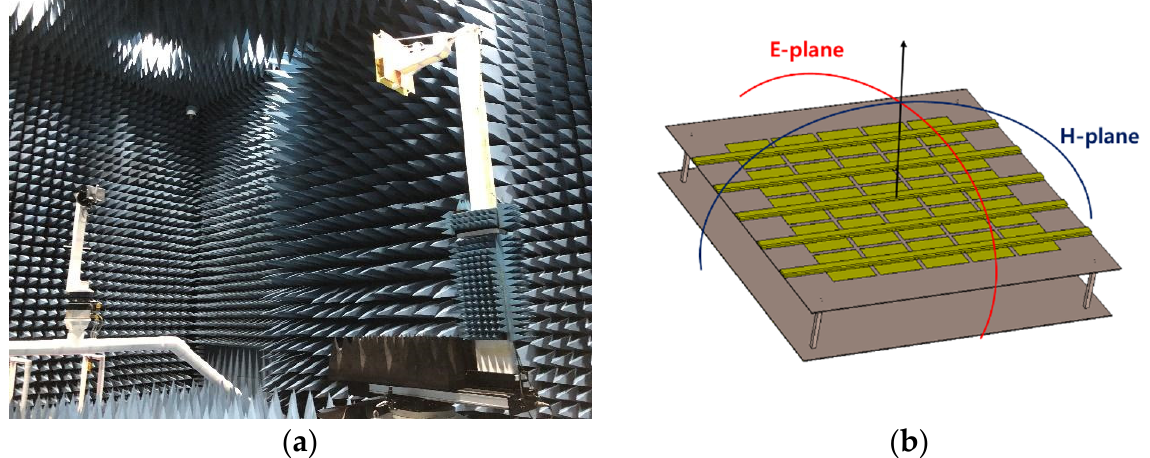
Figure 10. ( a ) Antenna radiation pattern and efficiency measurement environment; ( b ) measured plane.